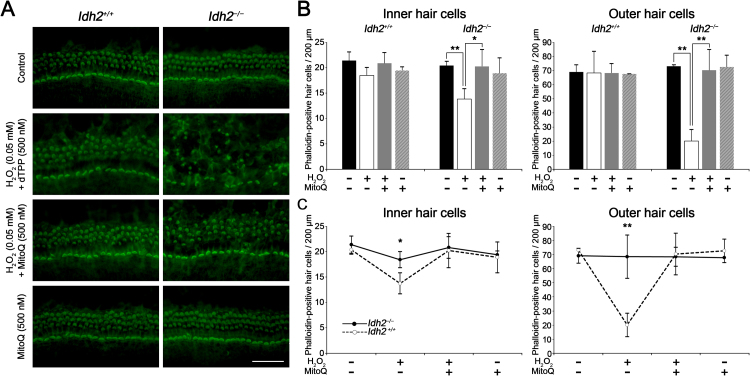
Evaluation of protective effect of MitoQ on H2O2-induced ototoxicity inIdh2+/+andIdh2−/−cochlear explants. (A) Immunofluorescent images represent the organ of Corti explants from each experimental group. Hair cells were stained with phalloidin (green). Scale bars: 50 µm. (B and C) Quantitative comparison of phalloidin-positive inner and outer hair cells in Idh2+/+ and Idh2−/− mice within a 200-μm region of the organ of Corti (n = 3). Data are shown as the means ± SEM. *p < 0.05, ** p < 0.005.